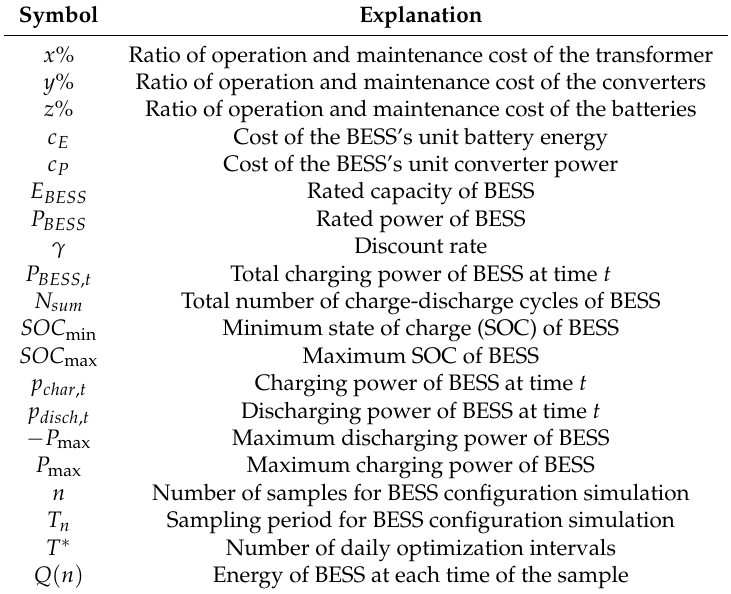
Number of daily optimization intervals Energy of BESS at each time of the